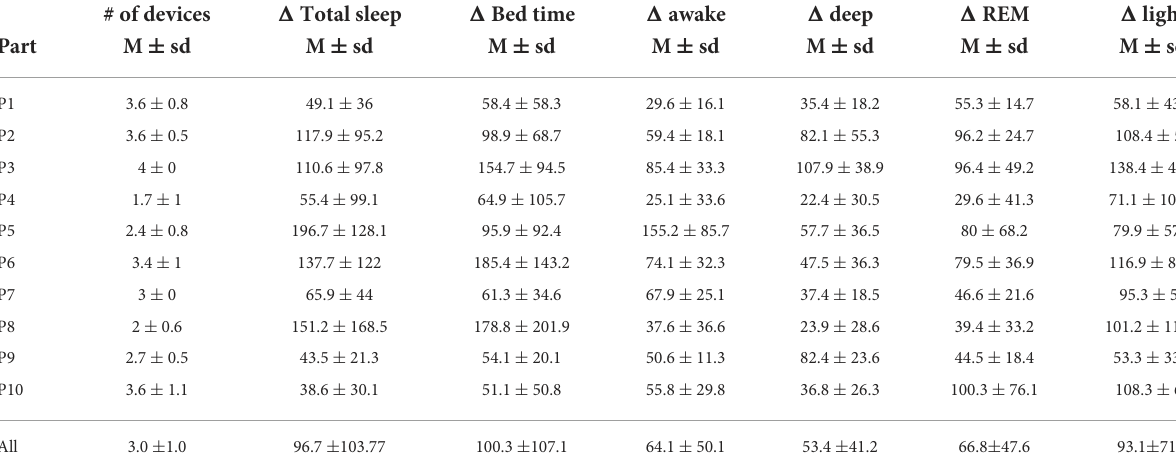
TABLE 6 Mean difference between the lowest and highest result for each night for all parameters (in minutes).